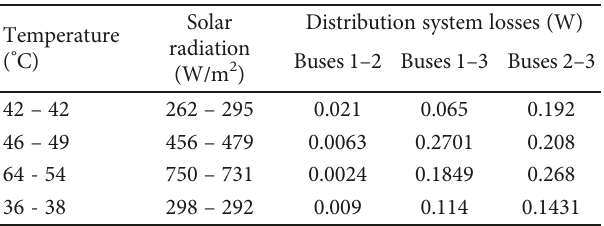
Table 4: Distribution losses of the single-source con fi guration. Temperature